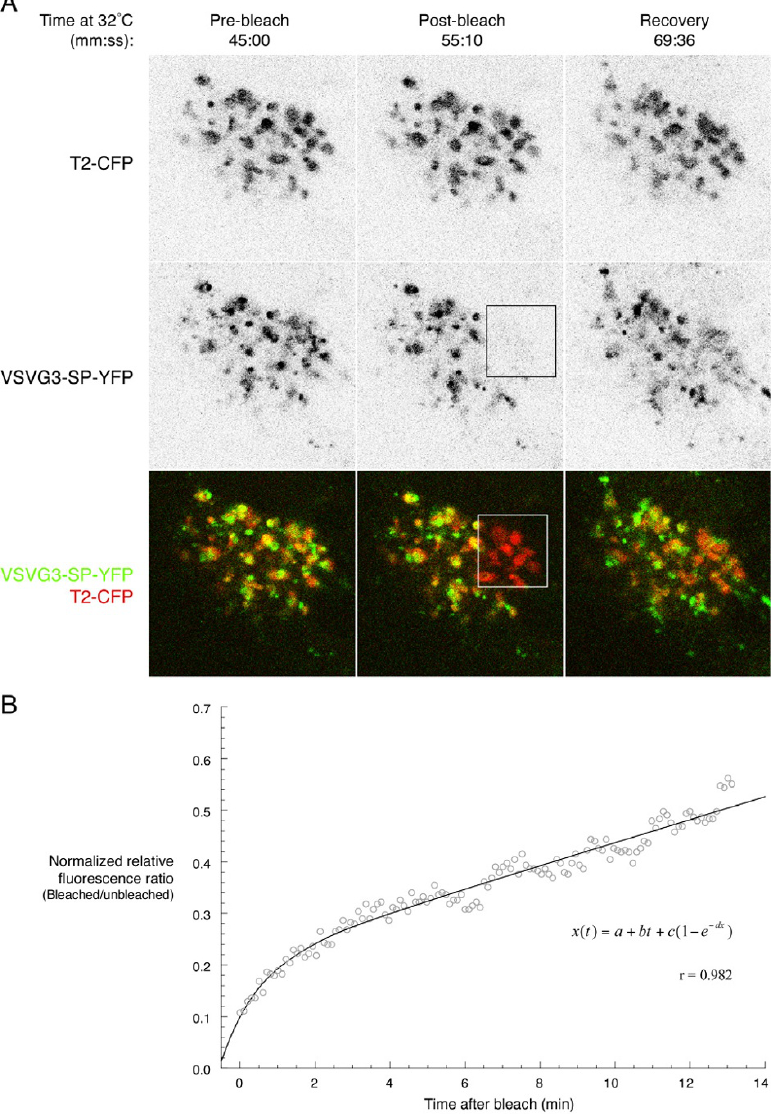
Figure 7 Transfer of cargo between regions of the Golgi has properties of diffusion and flow A. Cargo recovers into photob- leached Golgi elements. Transiently expressed VSVG3-SP-YFP cargo was accumulated in the ER and pulsed into the secretory pathway of PtK 2 cells as in Figure 1B. After 55 minutes at 32 ° C, (well past the period when cargo is entering the Golgi from the ER), a region covering several Golgi elements was bleached in the YFP channel. The CFP channel was monitored but not bleached. After the bleach, both channels were imaged at 6 second intervals for 15 additional minutes. The total intensity of cargo within all Golgi elements decreases because cargo continues to exit the Golgi during this time, but the relative level of cargo in the bleached region with respect to unbleached region increases, indicating exchange of cargo between the bleached and unbleached regions. Figure 7A corresponds to frames from the movie in Additional Fileset 7. Bar: 10 µ m. B. Cargo exchange between Golgi regions is consistent with two underlying processes. Quantitation of the experiment in A as described in Materials and Methods. Cargo fluorescence is normalized for overall loss of cargo from the Golgi due to Golgi exit and for fluctuations due to cell movement and recovery is plotted against time (open circles). The equation shown was fit to the data (line). Due to normalization, the average pre-bleach value of cargo and normalized Golgi resident fluorescence is 1. The analy- sis relies on the assumption that cargo exits the Golgi equivalently from the bleached an unbleached region, and that CFP and YFP fluorescence remains constant during the experiment (Figure 1). The data are fit well by the equation shown, indicating recovery can be described by sum of linear and exponentially decaying